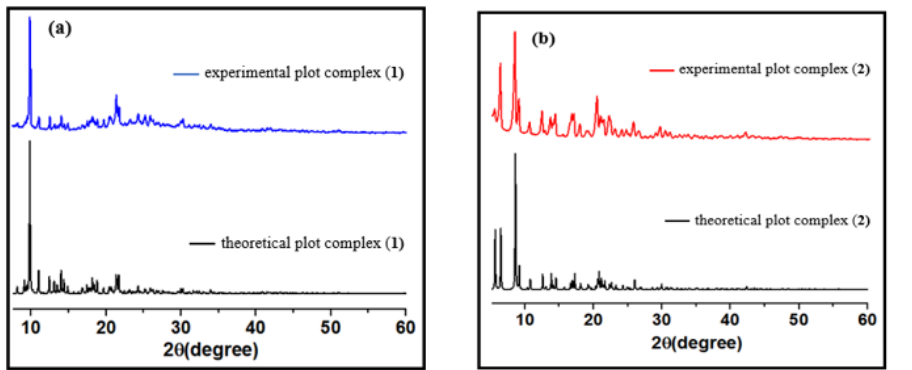
Figure 13. ( a ) Theoretical and experimental P-XRD patterns of complex 1 , and ( b ) theoretical and experimental P-XRD patterns of complex 2 .